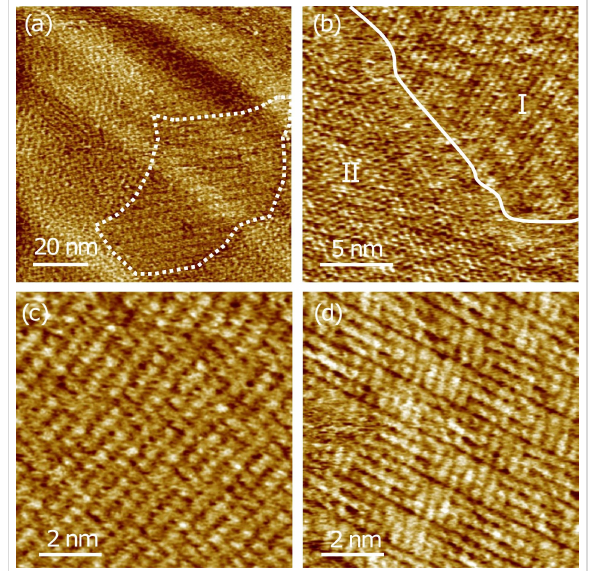
Figure 2: Polymorphic self-assembly of 1 at the solution–solid inter- face. (a) Large-scale STM image; V s = 1.4 V, I t = 1 nA. (b) STM image showing two polymorphs separated by a domain boundary indicated by a solid white line. V s = 0.8 V, I t = 400 pA. (c, d) STM images with sub-molecular resolution depicting the molecular packing in the two polymorphs mentioned in the text; V s = 0.6 V, I t = 500 pA.